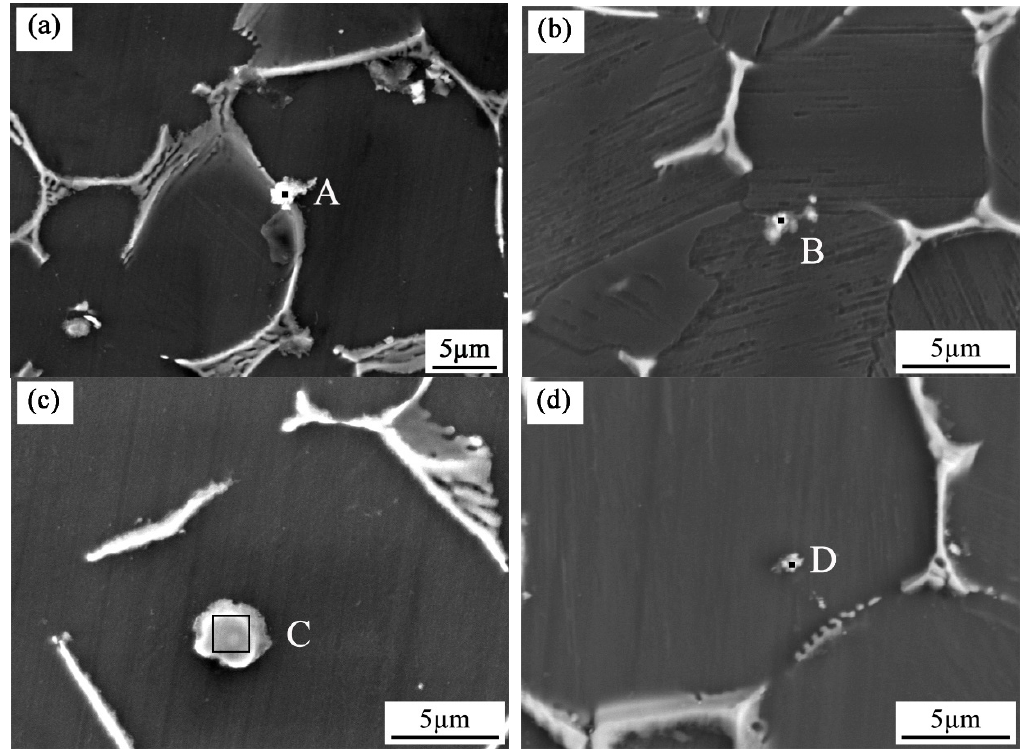
Figure 7. Content of solute elements within grains.